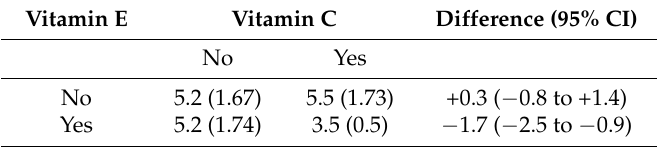
Table 3. Interaction between vitamin C and vitamin E in the Abdoulhossein (2018) trial. Vitamin